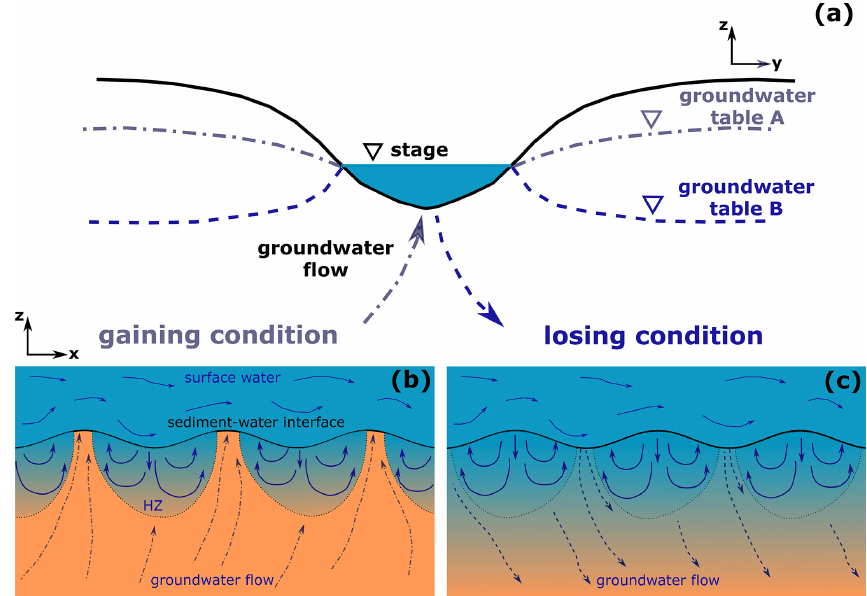
Figure 1. Schematic description of (a) gaining and losing groundwater systems and bedform-induced hyporheic exchanges under (b) gaining and (c) losing conditions. The river can be gaining when groundwater discharges into the river (scenario of groundwater table A) or losing when the river recharges the aquifer (scenario of groundwater table B). Different directions of groundwater flow result in substantially different flow field, location, and geometry of hyporheic